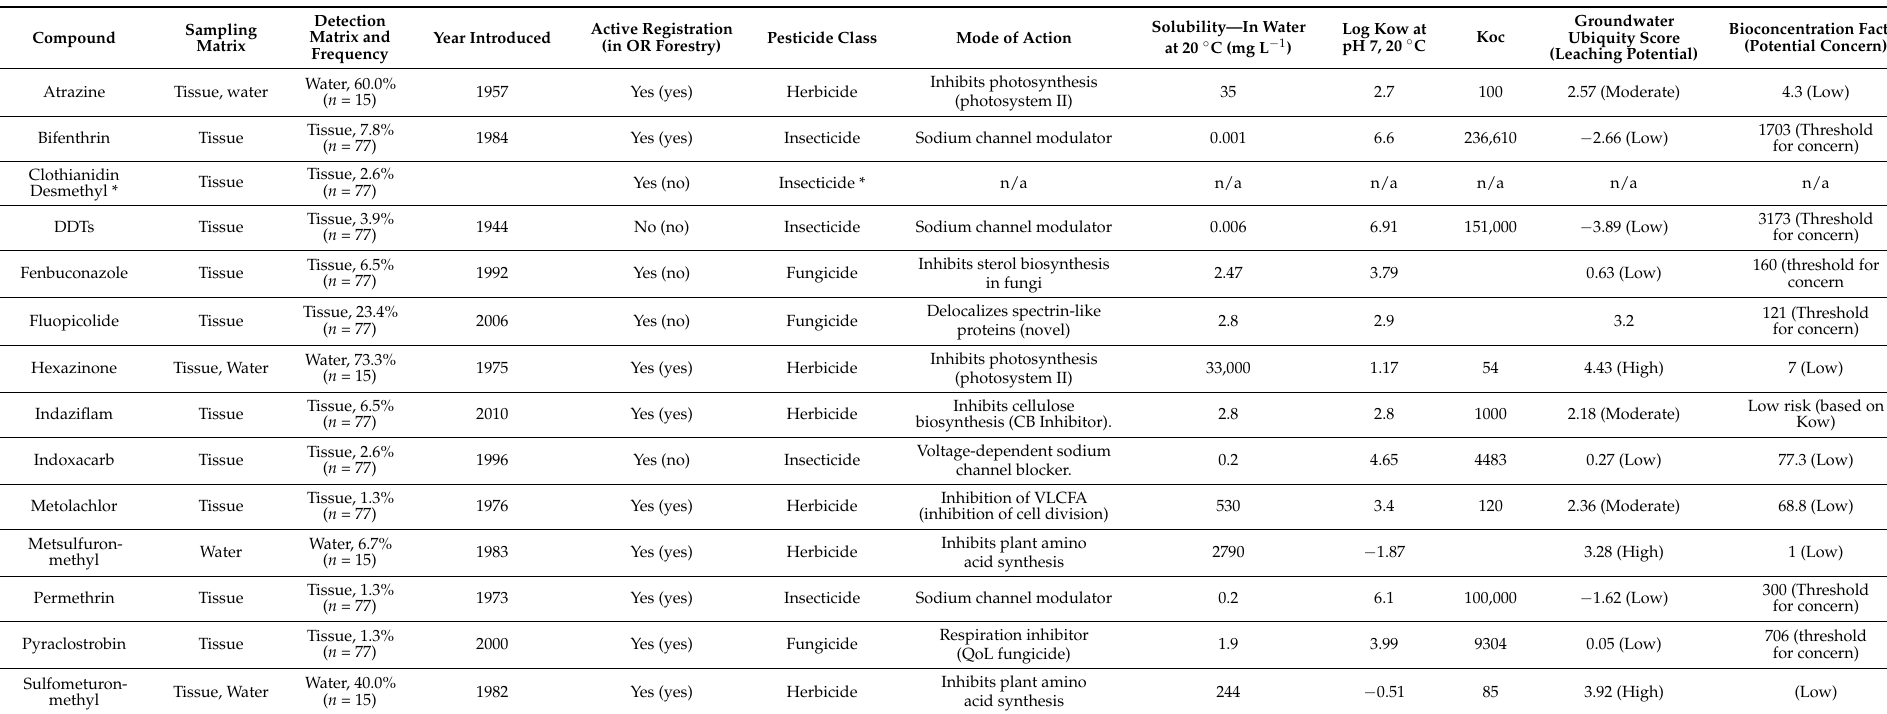
Table 4. Detection frequency, current status, and matrix of compounds observed in tissue and water sampling; along with pesticide characteristics that explain environmental behavior [22,60]. * indicates a metabolite of a parent compound in this